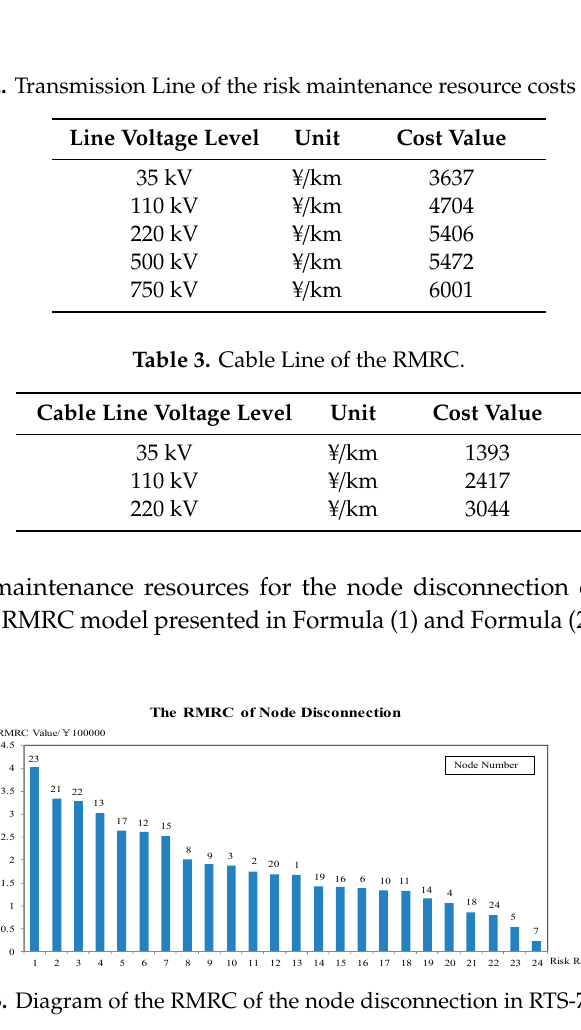
Figure 4. Diagram of risk rating based on the node disconnection severity (NDS) in the RTS-79 system. Figure 4 shows that the node disconnection severity (NDS) value decreases from left to right, the corresponding node is disconnected, and the generalized load loss of the system goes from large to small. In this power system, the node at the first risk rating level based on NDS is node 23, which has the largest NDS value. The NDS values of node 11, node 12, node 17 and node 24 are equal to 0 because these nodes have no access to the generator or load. The risk ratings of the 24 nodes of the RTS-79 system are based on the criterion of the node disconnection probability (NDP). The risk rating results are shown in Figure 5.